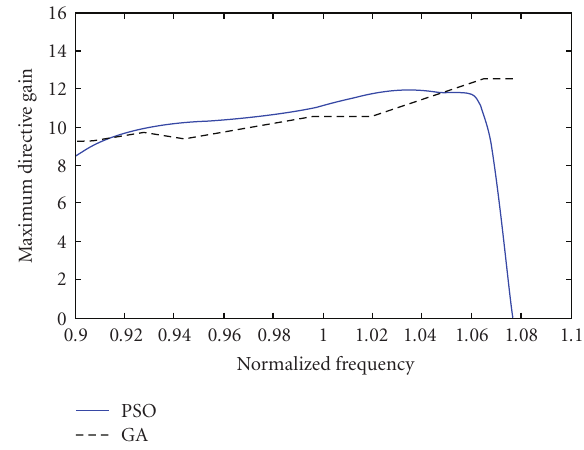
Figure 2: Maximum directive gain in dB versus normalized frequency for GA and